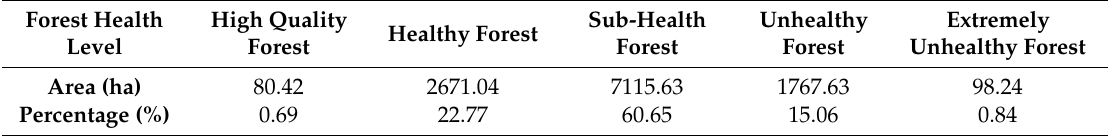
Table 8. Statistics of forest ecosystem health level of Mount